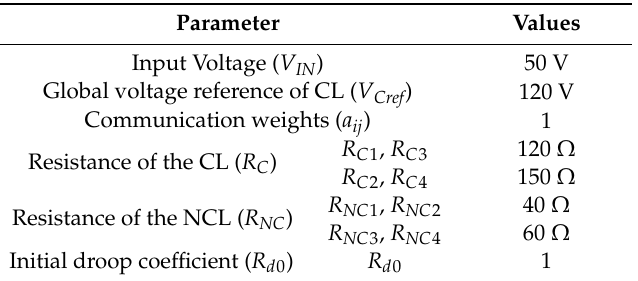
Table 1. Parameters for simulations.